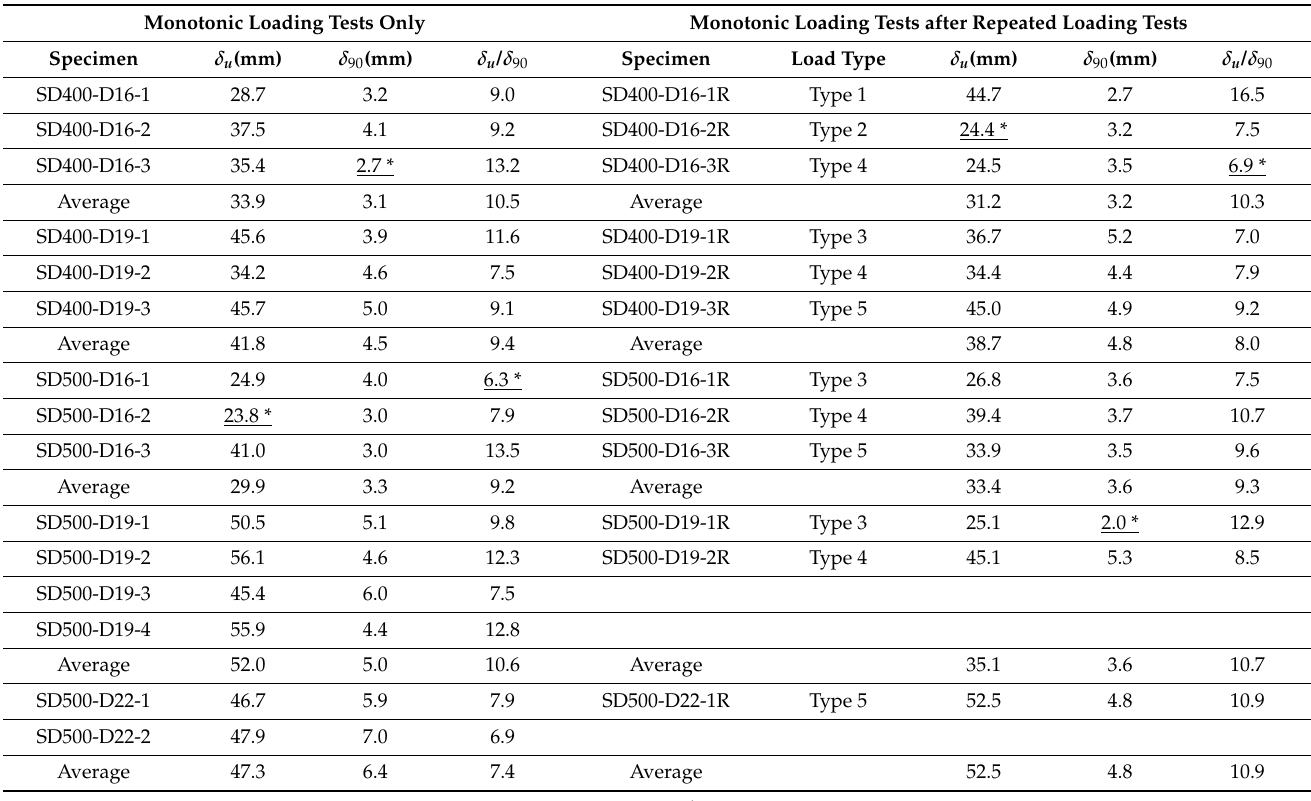
Table 12. Characteristic values of displacement ductility according to load